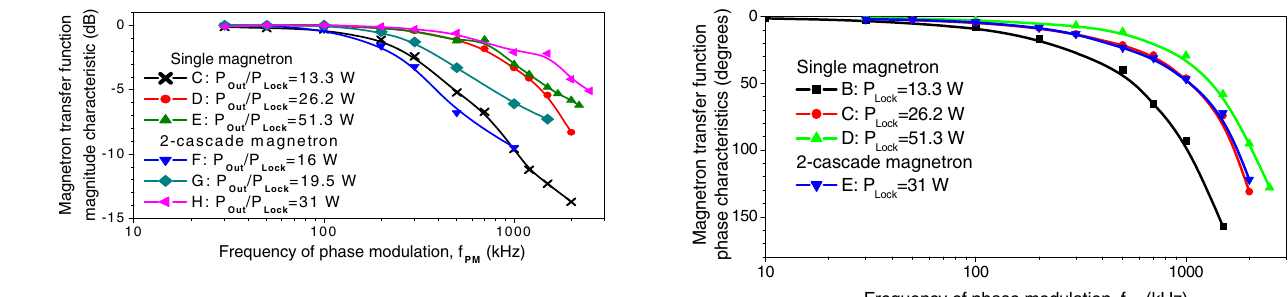
FIG. 9. Transfer function magnitude characteristics of the phase control measured in the phase modulation domain with single and FIG. 10. Transfer function phase characteristics of single and 2- 2-cascade injection-locked magnetrons at various power levels of cascade magnetrons injection locked by the phase-modulated the injection-locking signal, P . Lock signal vs the modulating frequency, f PM